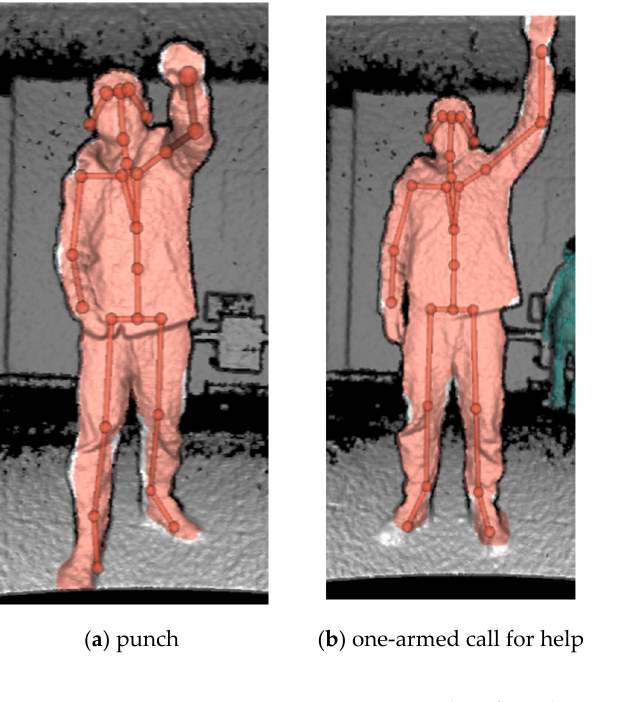
Figure 9. Examples of six abnormal actions. Table 6. Group settings and numbers of experimental